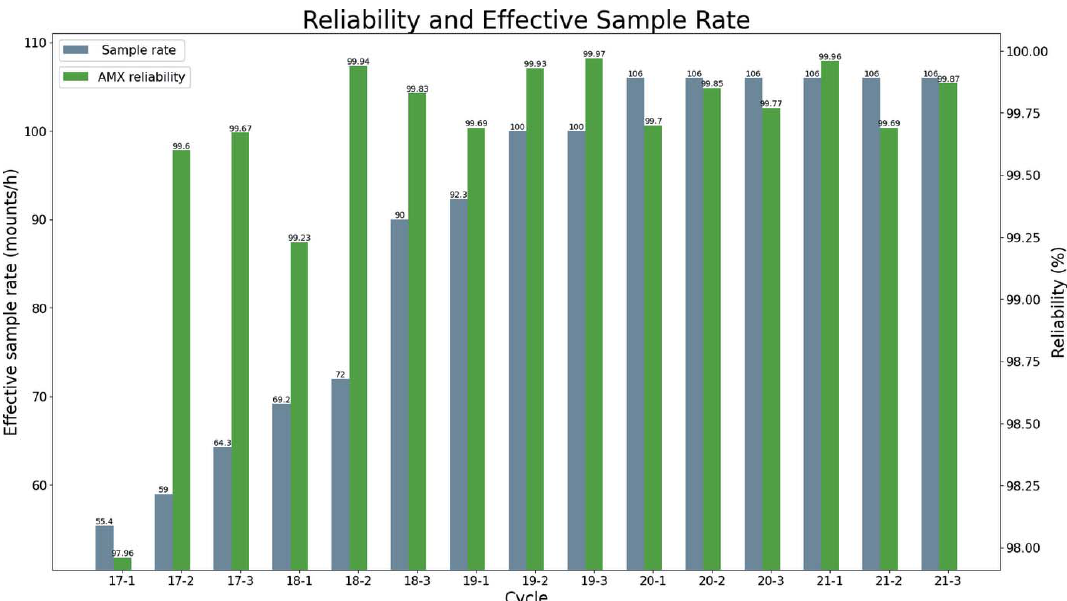
Figure 5 The sample rate (gray) is the number of samples the robot can mount excluding all other procedures such as crystal centering or data collection. Green represents reliability expressed as the percentage of successfully mounted samples. For a detailed definition of reliability, see Lazo et al.